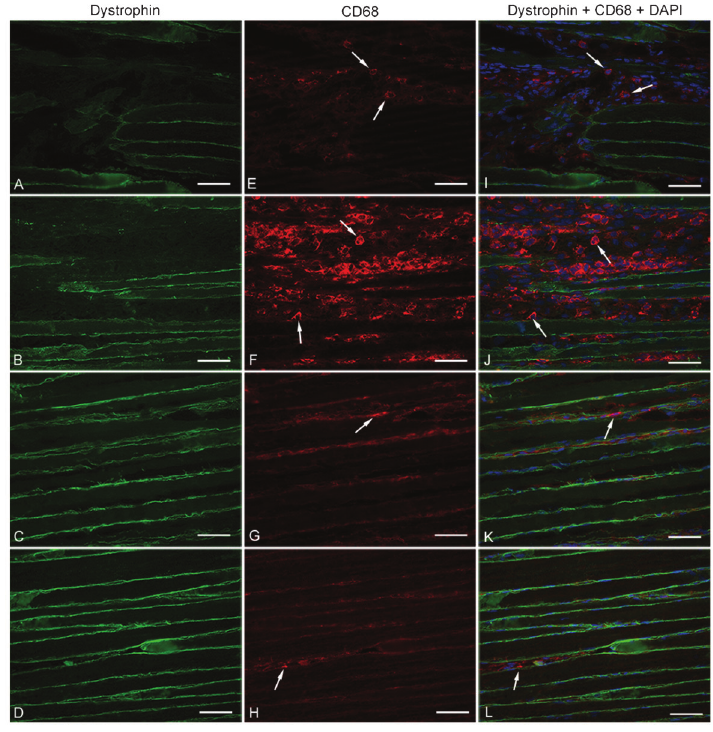
Figure 3. Photomicrographs of the soleus muscle of the animals in groups IF (3) , IS (3) , IF (10) , and IS (10) , A - L : Longitudinal sections immunolabeled with rabbit polyclonal anti-dystro- phin (green fluorescence) and mouse monoclon- al [ED1] anti-CD68 (red fluorescence) antibodies, nuclear fluorescent staining defined by DAPI (blue fluorescence). A [IF (3) ] and B [IS (3) ]: Staining discontinuity, sarcolemmal undulations and sparse staining for dystrophins. C [IF (10) ] and D [IS (10) ]: Staining thickness and some sarco- lemmal undulations. E [IF (3) ], F [IS (3) ], G [IF (10) ], and H [IS (10) ]: Immunofluorescent staining of the CD68 protein expressed in the cellular mem- brane of macrophages (arrows). I [IF (3) ], J [IS (3) ], K [IF (10) ], and L [IS (10) ]: Merged images of dystrophin, CD68, and DAPI. Observe the loca- tion of macrophages and their respective nuclei (arrows). See Figure 1 legend for explanation of abbreviations. Scale bars: 50 m m.